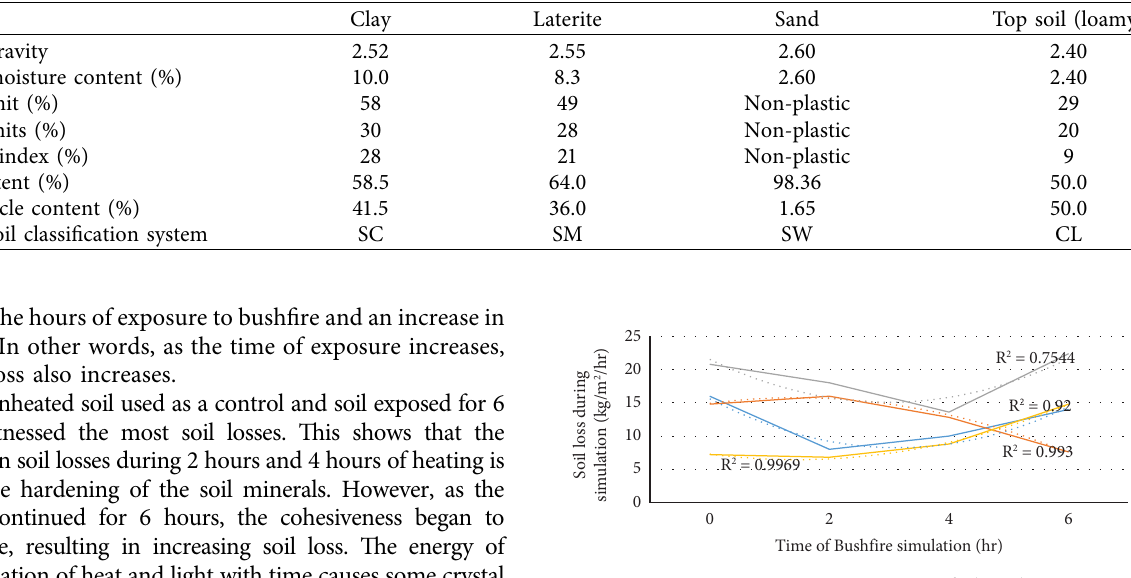
Figure 2: Rainfall simulation test of the heat-treated Table 1: Index properties of soils used for the study.